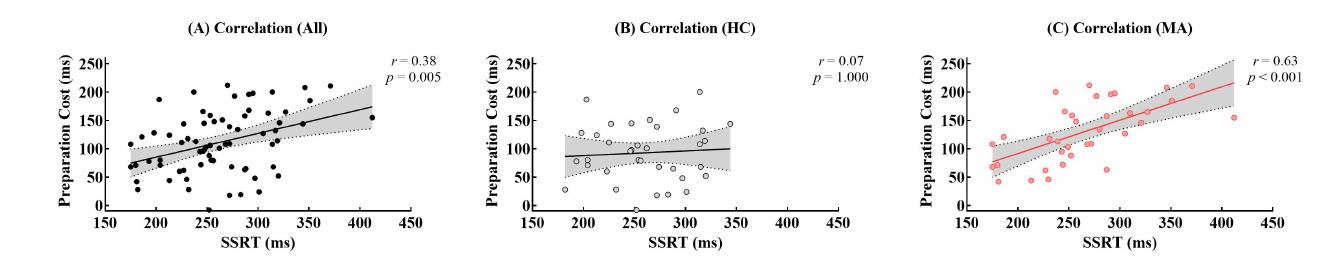
Figure 3. Scatter plots of preparation cost and SSRT with regression lines and 95% CIs in all par- ticipants ( A ), and the HC ( B ) and the MUD groups ( C ). Note: CI, confidence interval; r , Pearson correlation coefficient; p values corrected by FDR.